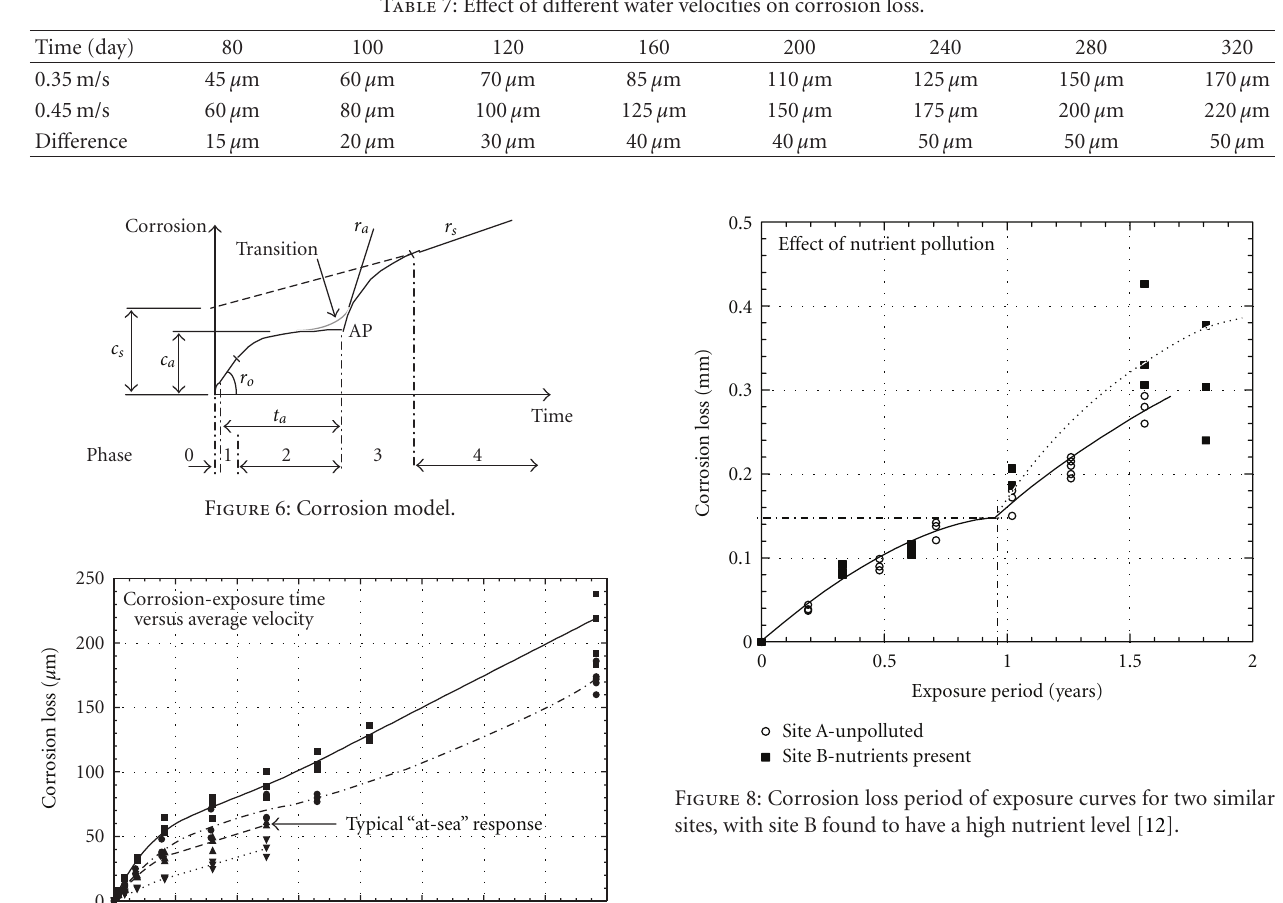
Table 8: Comparison by polluted and unpolluted